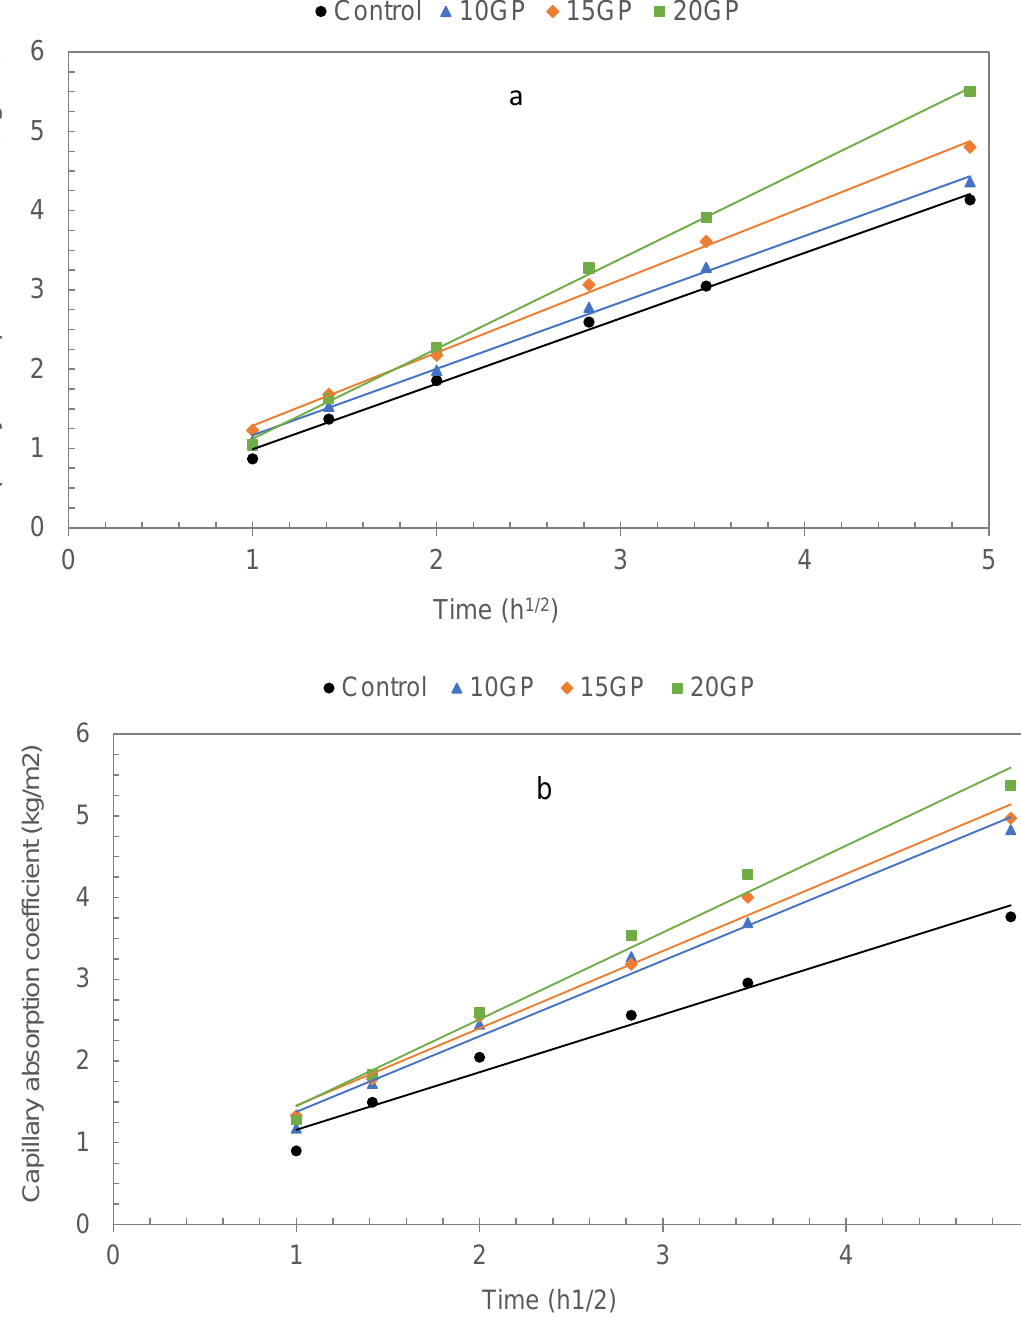
Figure 12. Capillary absorption and sorptivity of 28 days ( a ) and 90 days ( b )